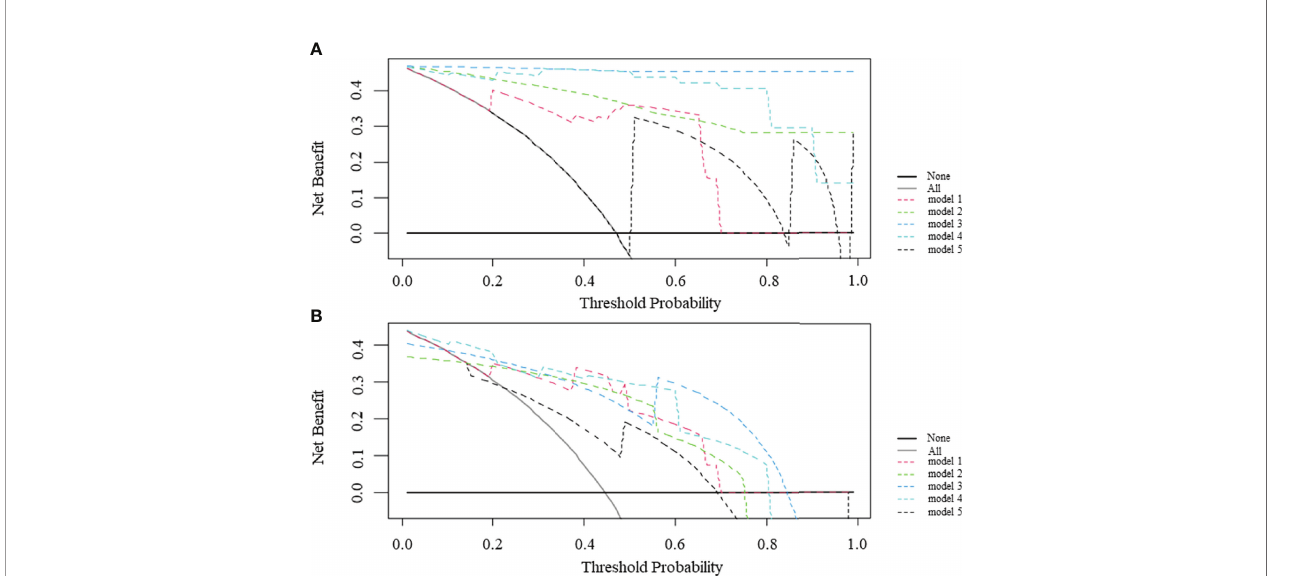
FIGURE 5 | Decision curve analysis (DCA) comparing the net bene fi ts of different models in the training cohort (A) and validation cohort (B) . The y-axis measures the net bene fi t and the x-axis indicates the threshold probability. model 1 = radiomics model_IVC; model 2= radiomics model_TT; model 3 = combined model_IVC; model 4 = combined model_TT; model 5 = radiological